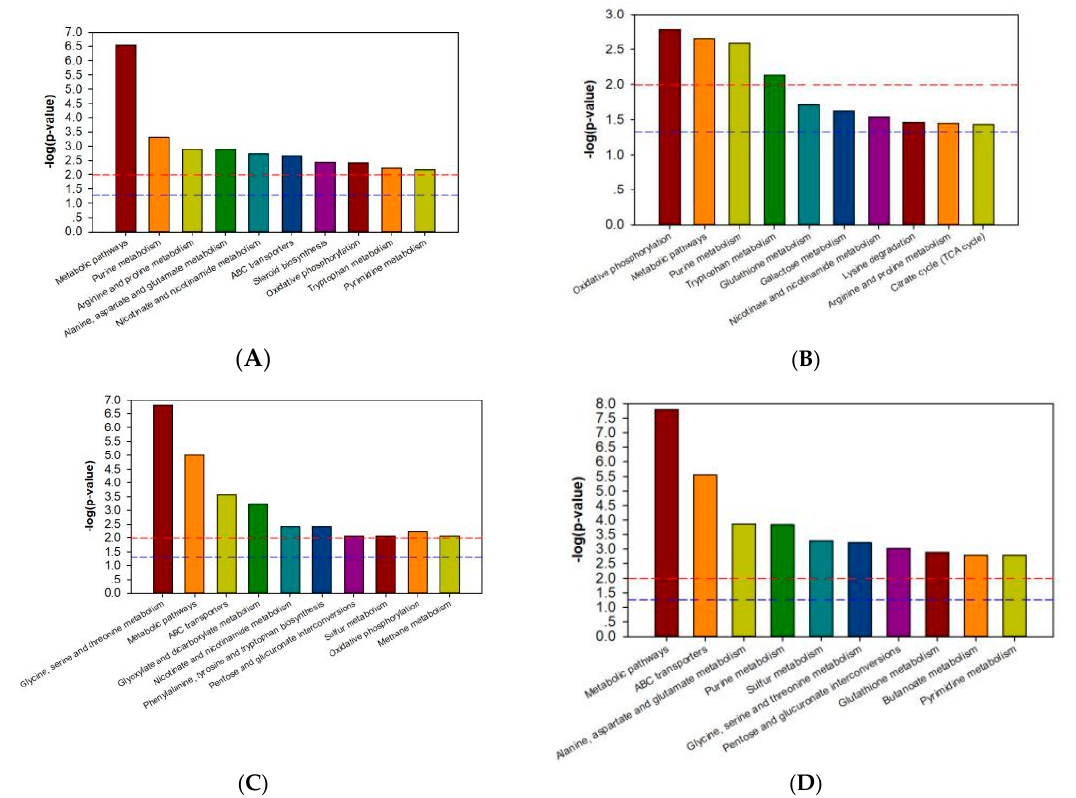
Figure 3. Categories of pathways in which the identified metabolites are involved. ( A ) metabolic pathway enrichment map of T6_F-T6_C; ( B ) metabolic pathway enrichment map of 733xin_F-733xin_C; ( C ) metabolic pathway enrichment map of T6_C-733xin_C; ( D ) metabolic pathway enrichment map of T6_F-733xin_F.